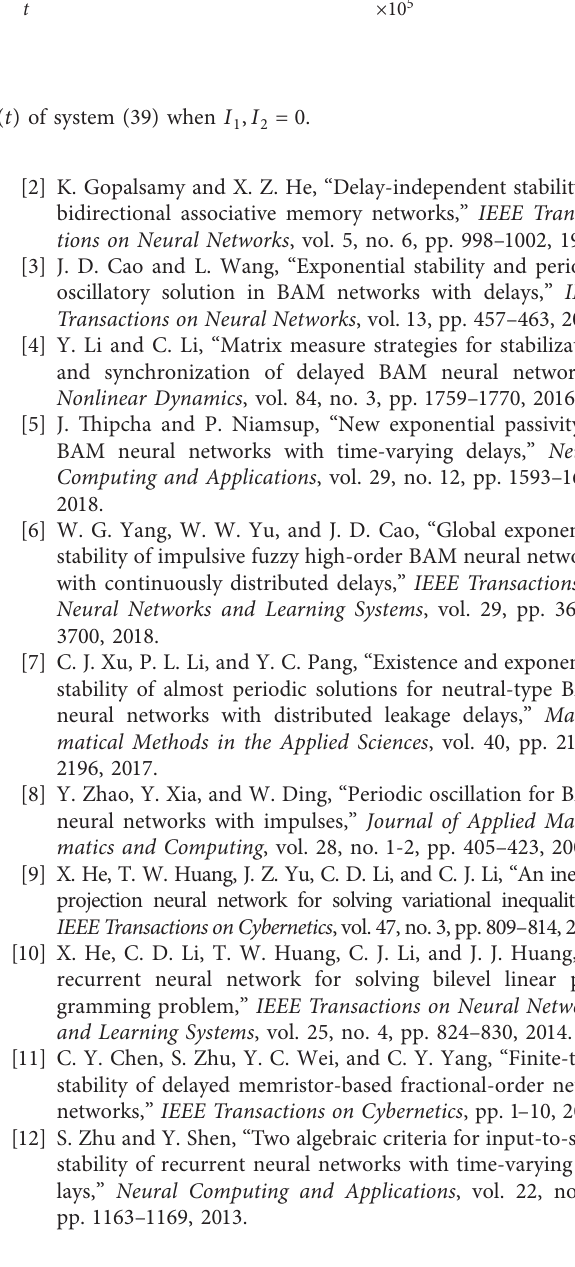
Figure 2: Time evolutions x